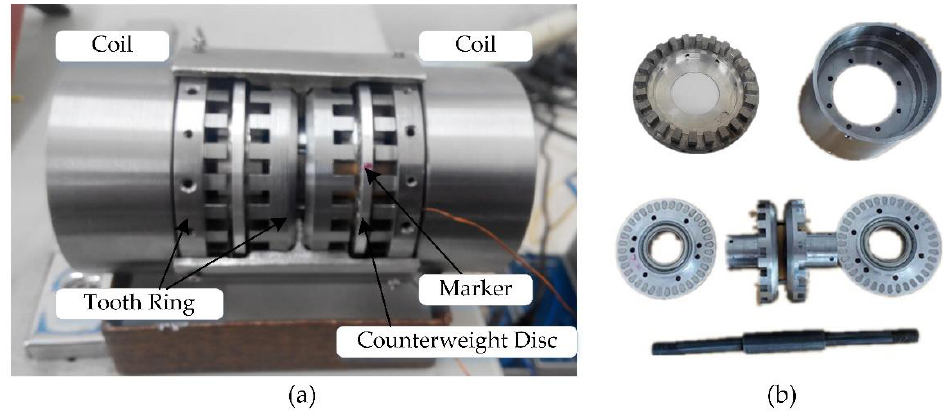
Figure 15. Picture of electromagnetic ring actuator: ( a ) Overall structure; ( b ) c omponent structure.